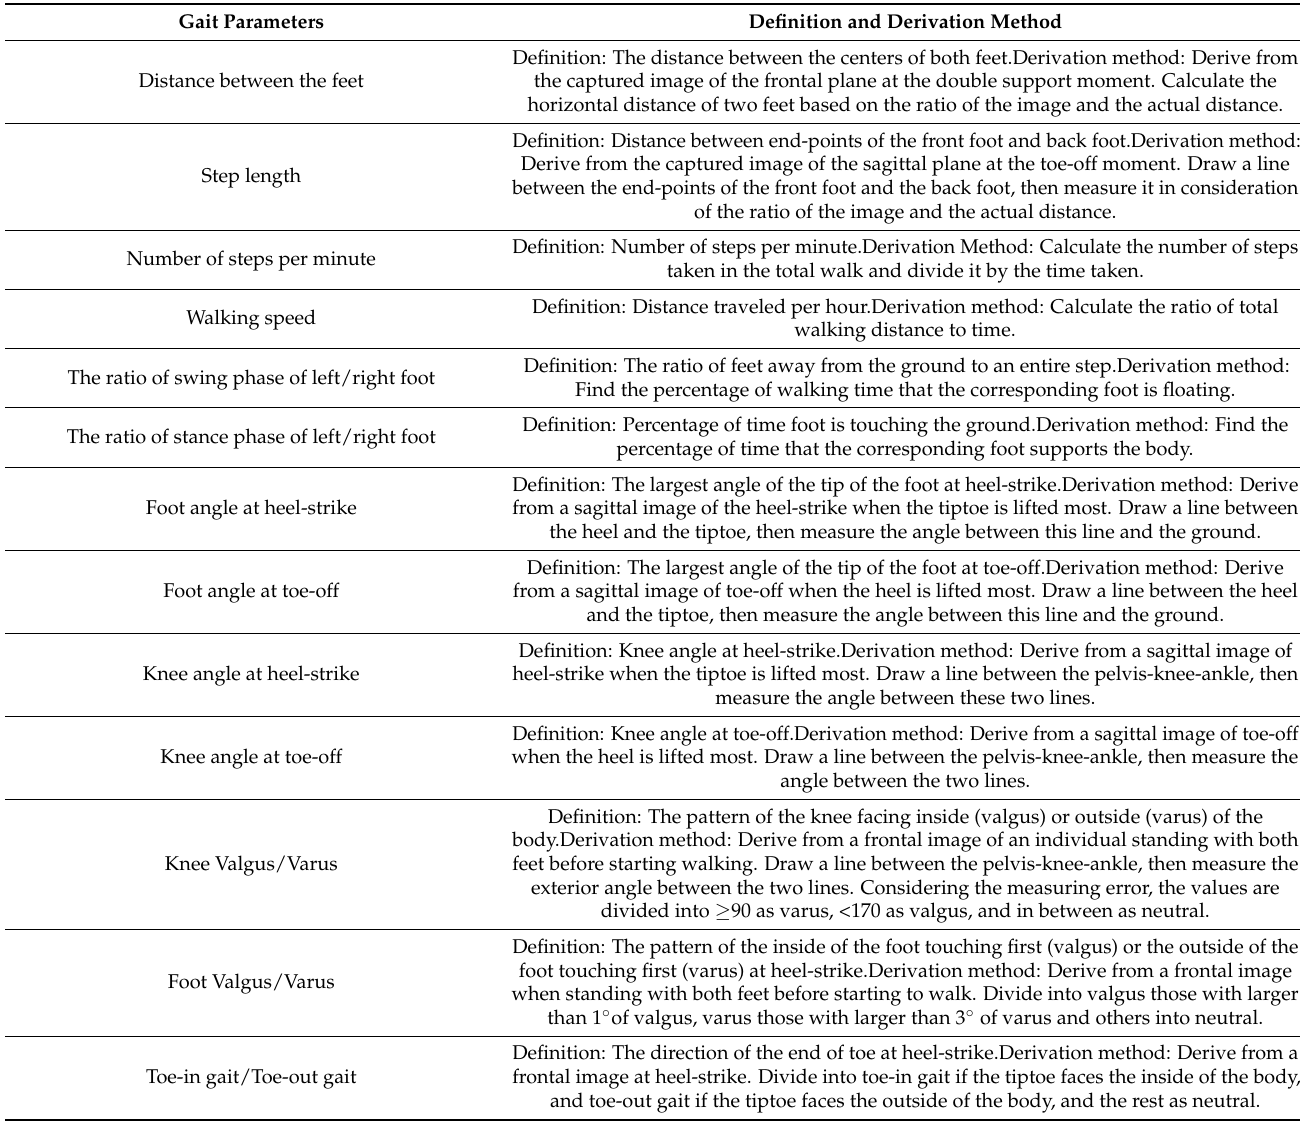
Table 2. Definition and derivation method of gait parameters of the lower